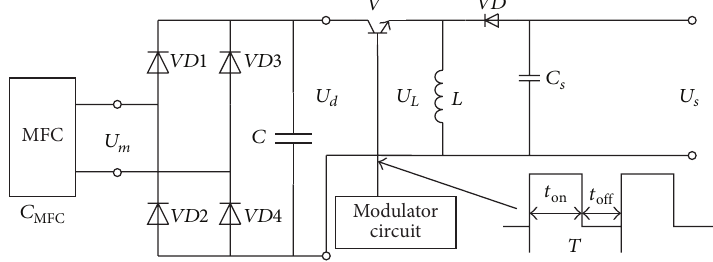
Figure 2: Schematic diagram of enhanced circuit